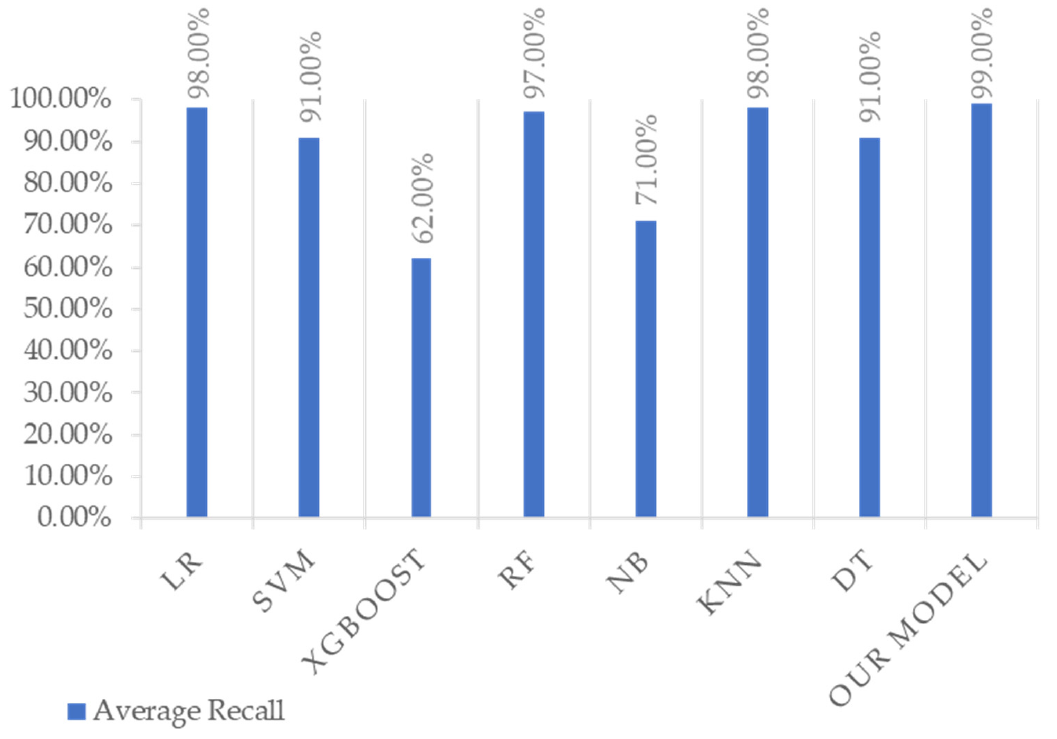
Figure A2. Comparison of the recall of our model with different algorithms.